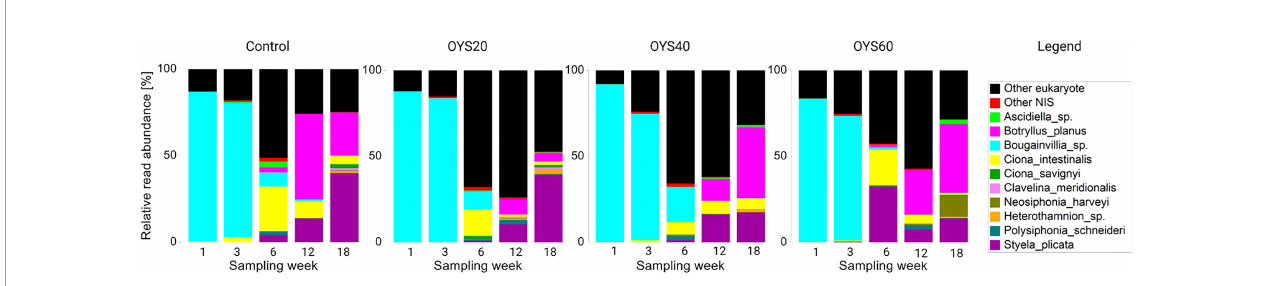
FIGURE 5 | Relative read abundance of non-indigenous species (NIS) and other eukaryotes per sampling week and polymer type. Only the ten most abundant NIS are shown for clarity; NIS with relatively low abundance were pooled in the ‘ Other NIS ’ category. See Supplementary Table S5 for a detailed list of